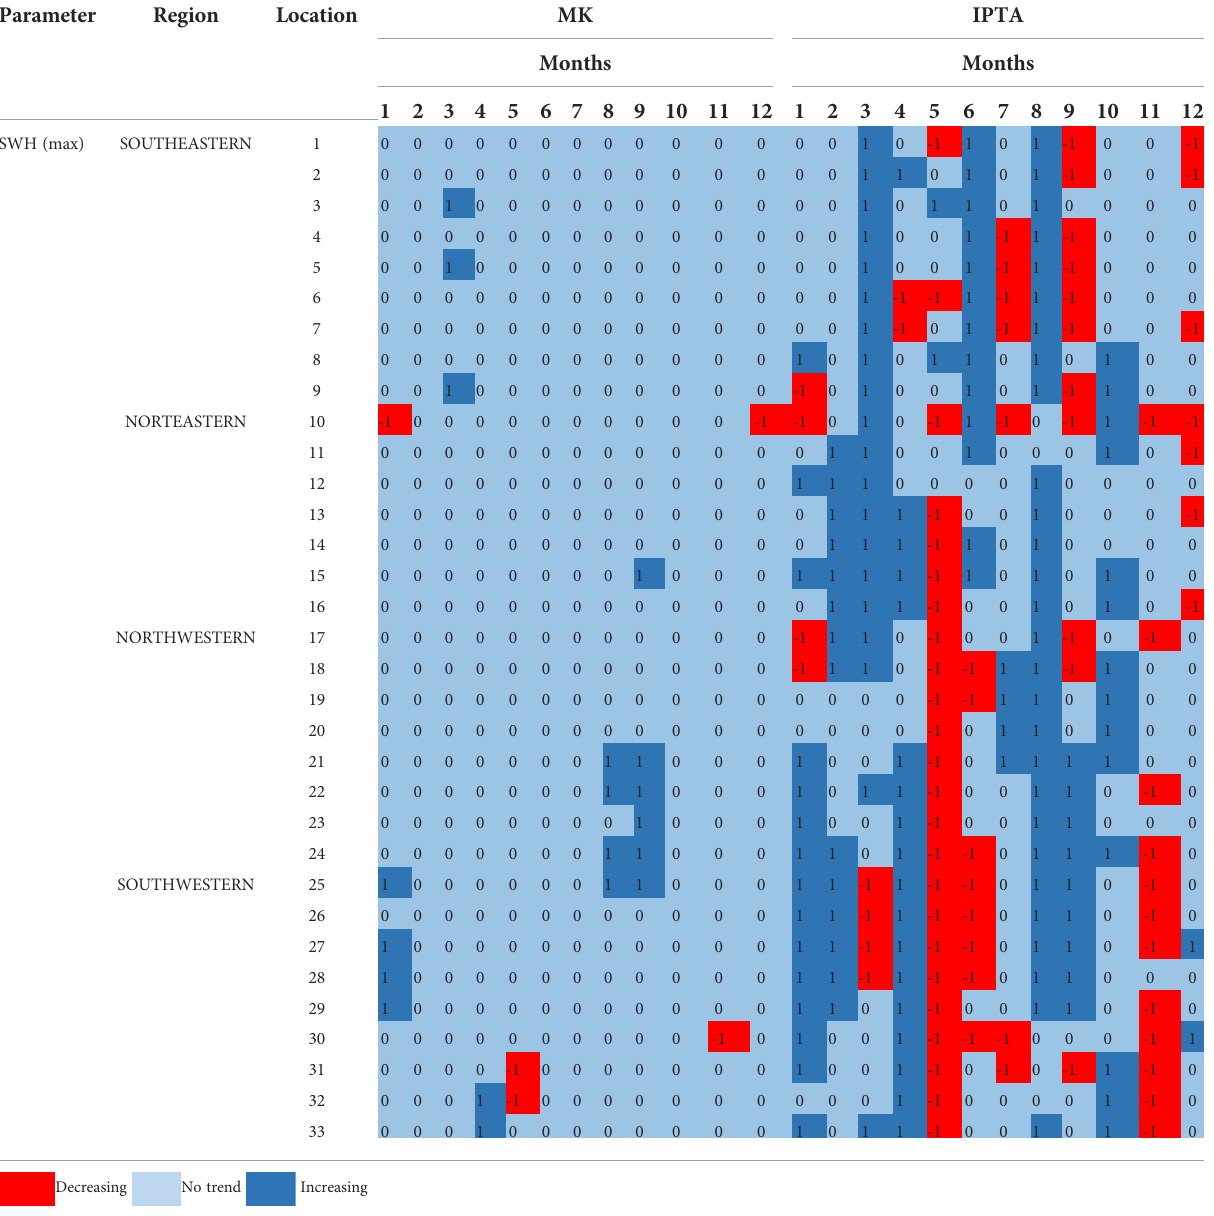
Table 4 that the relative error percentage of most of them is less than 5%.